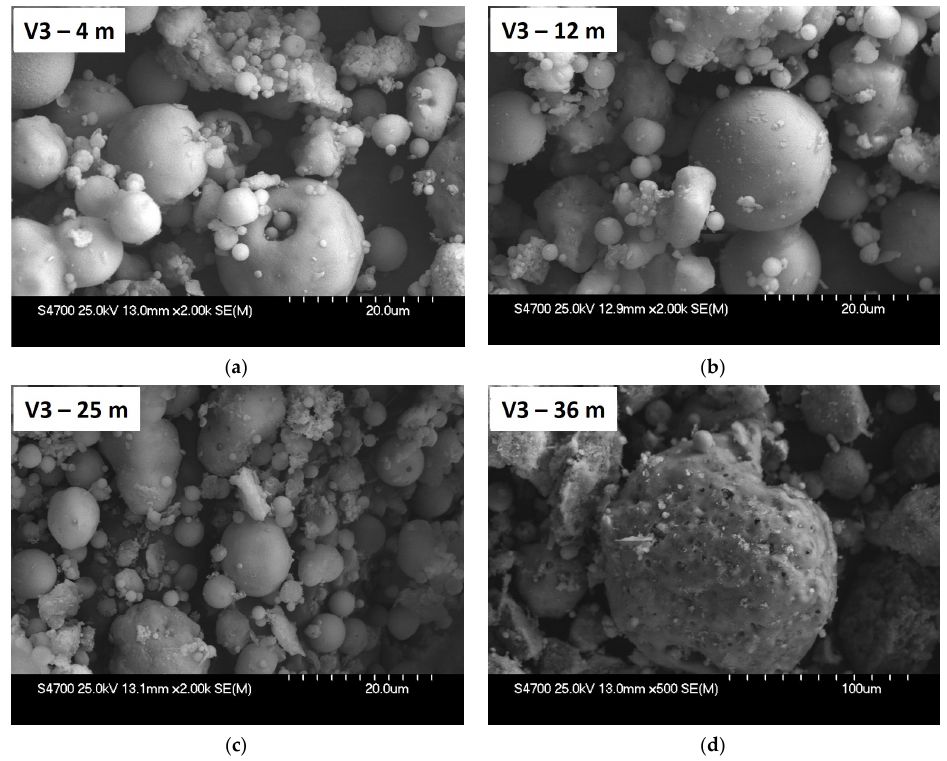
Figure 8. SEM Images of Agglomerates from Core Borehole V3 from Depths 4 m ( a ), 12 m ( b ), 25 m ( c ), magnified 2000× and 36 m ( d ), magnified 500×.